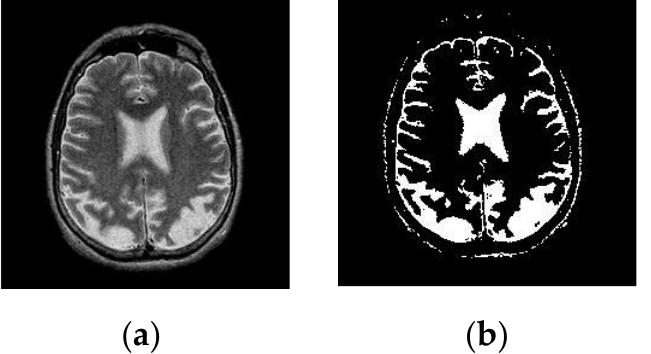
Figure 3. Here, image ( a ) is an input T-2 brain MRI image, whereas ( b ) is a segmented T-2 image. It is a Malignant Tumor according to the segmented picture.